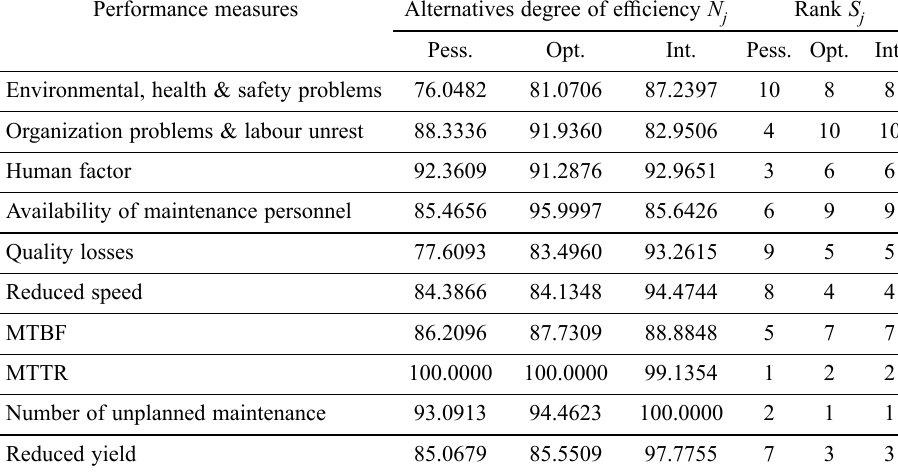
Table 7. Solution results for pessimistic, optimistic and interval values of initial decision